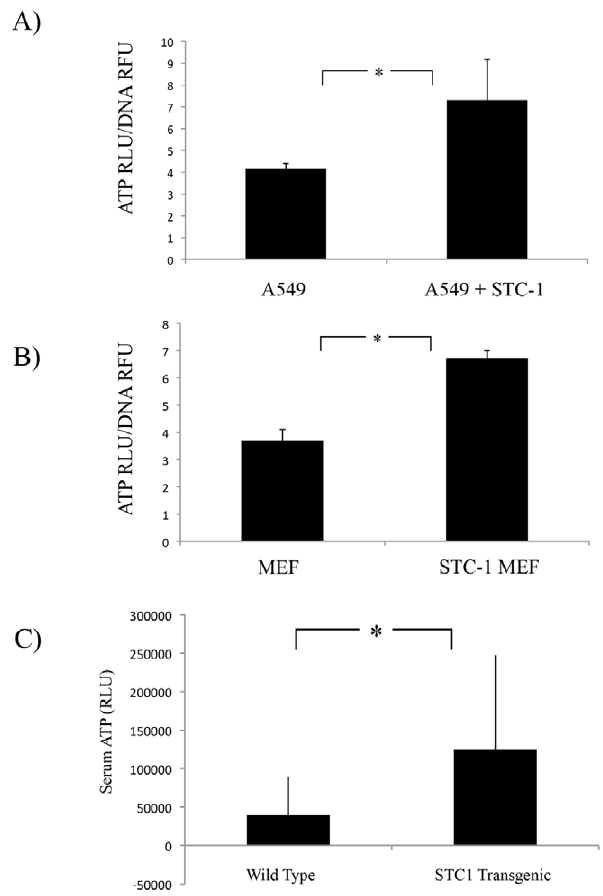
Figure 7. STC1 Enhanced the Release of ATP in vitro and in vivo. A) A549 cells were stimulated with 500 ng/mL STC1 for 10 mins. Conditioned medium was collected and assayed for ATP. Adherent cells were lysed and measured for ATP and DNA content. ATP values were normalized to DNA fluorescence. * = p , 0.05; n =3. B) A549 cells were stimulated with 10 m M ATP for 2, 5 and 10 mins. Assay of conditioned medium and cell lysates of wild type and STC1 over-expressing MEFs. * = p , 0.05; n =3. C) Serum was isolated from wild type and STC1 transgenic mice and assayed for ATP content. * = p , 0.05; n . 17.